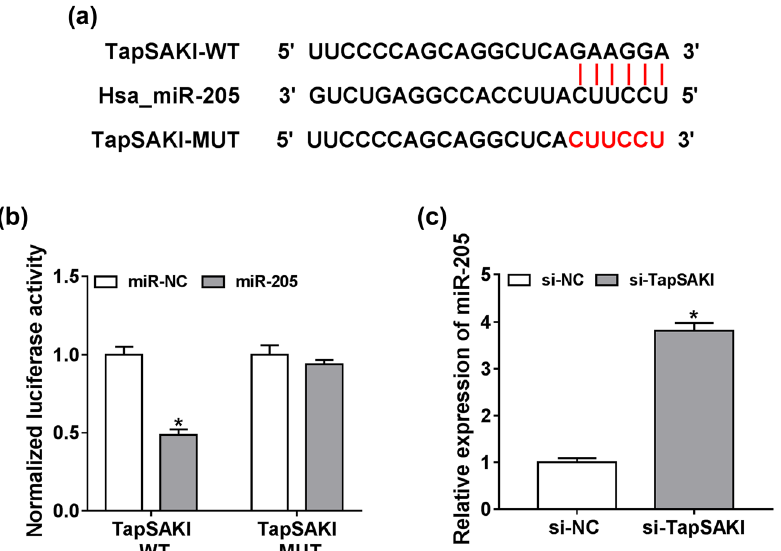
Figure 4: TapSAKI directly interacted with miR - 205. ( a ) Schematic of the complementary sequence for miR - 205 in TapSAKI identi fi ed by LncBase Predicted v.2 software and the mutant in the target sequence. ( b ) Dual - luciferase reporter assay in HK - 2 cells transfected with TapSAKI - WT or TapSAKI - MUT and miR - NC mimic or miR - 205 mimic. ( c ) The expression of miR - 205 by qRT - PCR in HK - 2 cells transfected with si - NC or si - TapSAKI. * P <